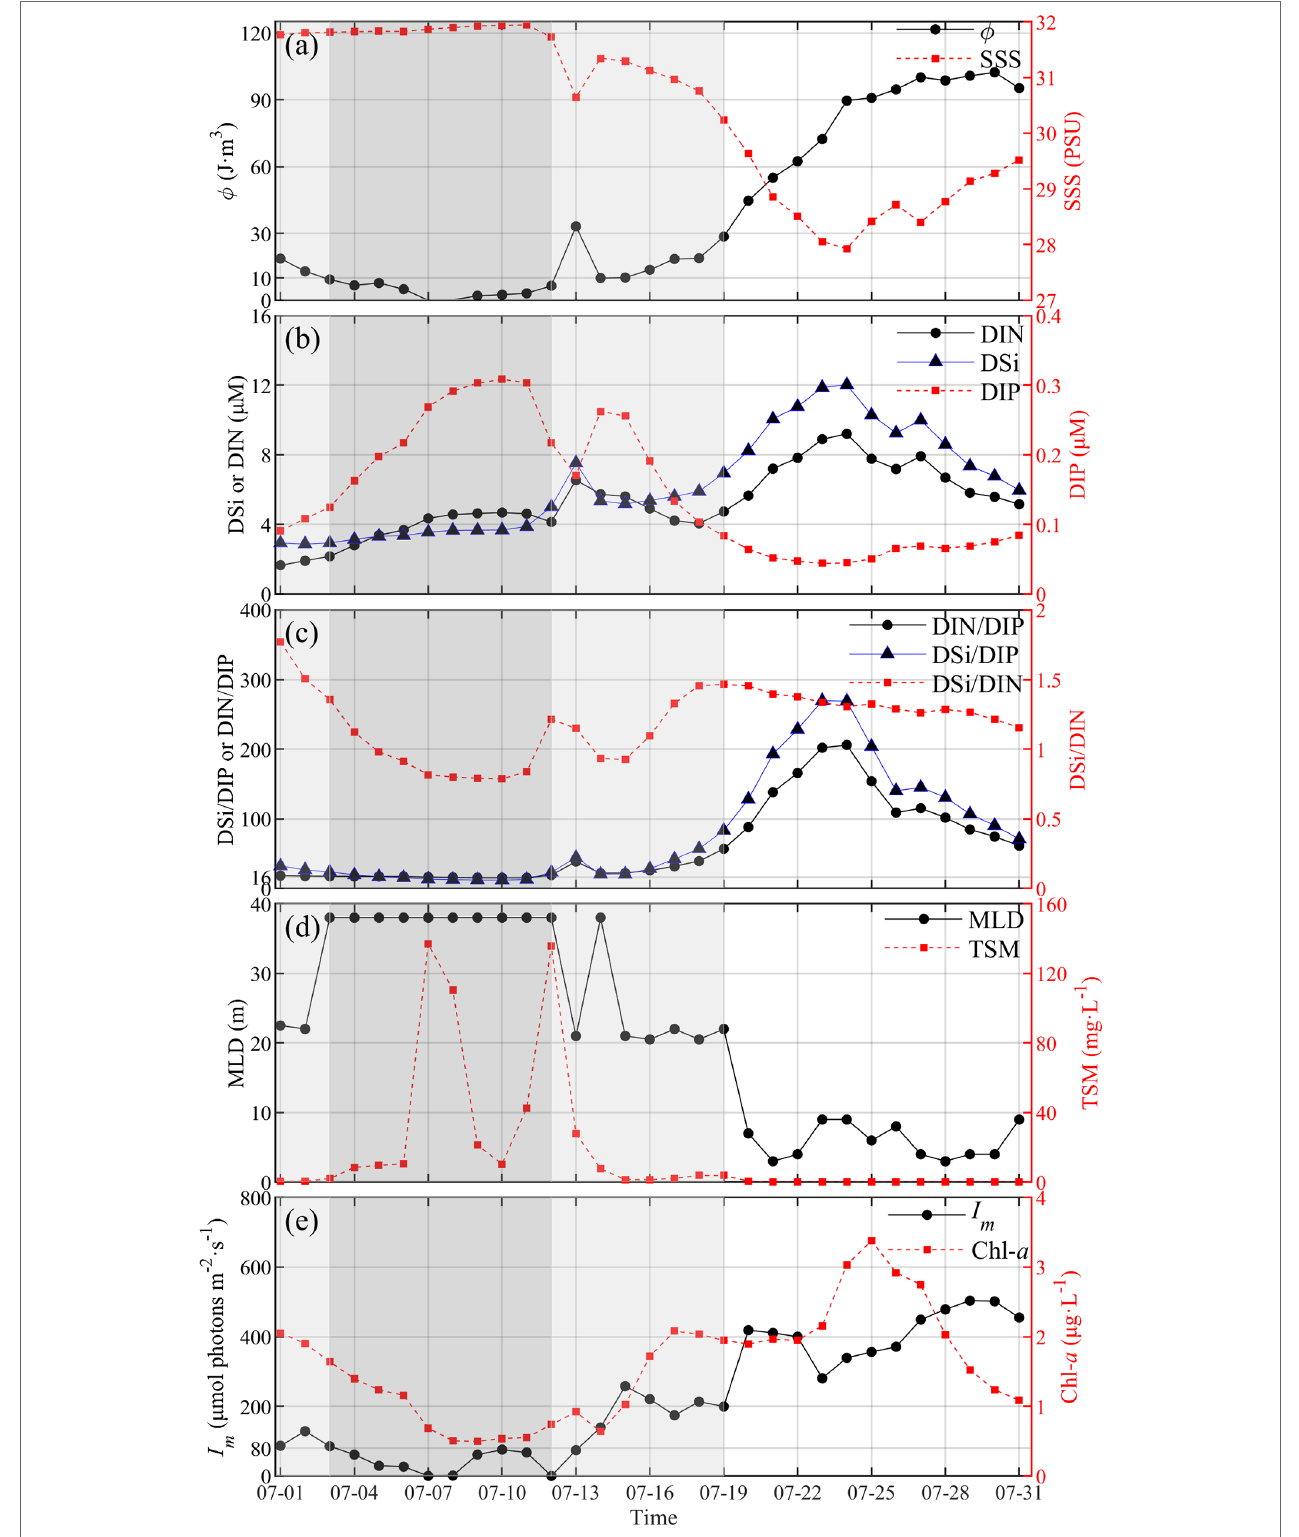
FIGURE 11 | Temporal variation of simulated physical and ecological variables at the center of CWZ during July 1–31, 2015. (A) Ø and SSS; (B) surface nutrient concentrations; (C) Surface nutrient ratio; (D) MLD and surface total suspended matter (TSM); (E) I m and surface Chl- a concentration. The state of water mixing and stratification is indicated by dark gray, light gray, and white, deep grey shaded period represents that the water column is fully